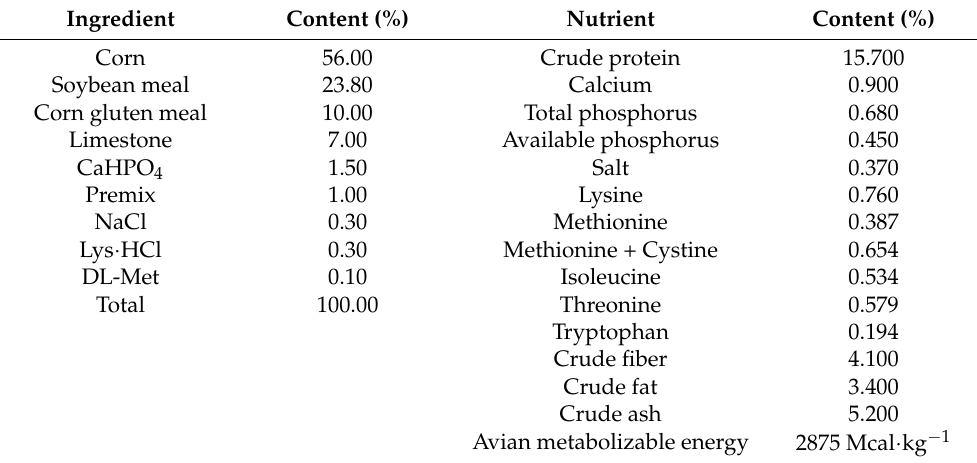
Table 1. The feed composition for black Muscovy